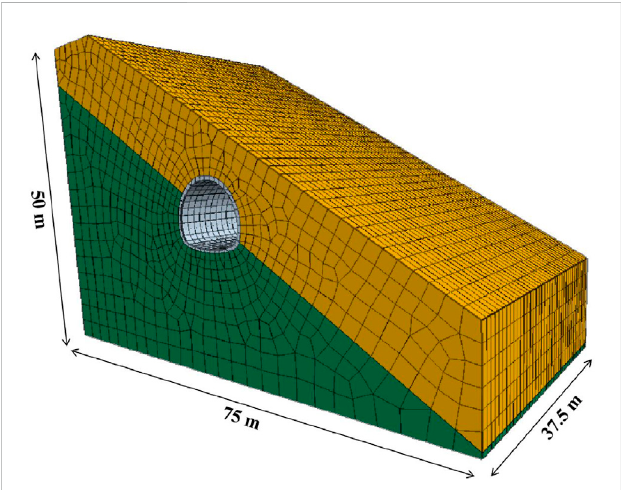
FIGURE 12 Numerical model of surrounding rock and supporting structure.